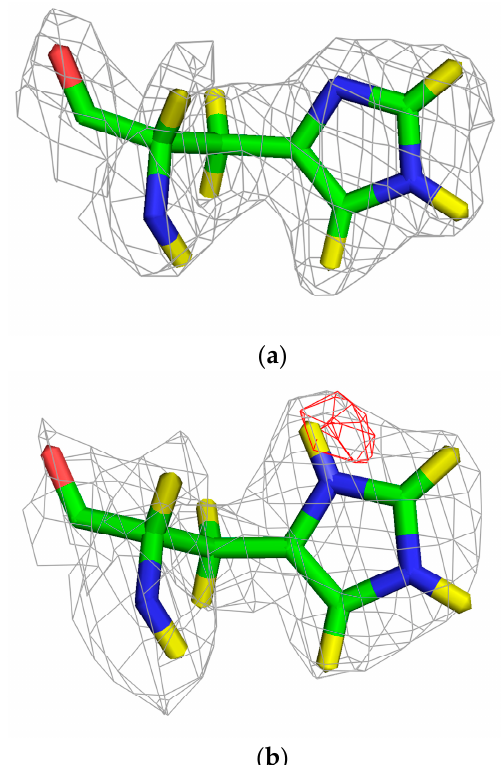
Figure 4. Protonation state of His30 in human MnSOD revealed by neutron diffraction. Carbons are green, nitrogens are blue, and oxygens are red. Deuterium (yellow) replaced hydrogen in the sample to increase diffraction signal. The 2F o -F c grey nuclear density is 1.0 σ . The red omit positive F o -F C nuclear density is at 2.5 σ . ( a ) Chain A of the neutron crystal structure displays an unprotonated His30. ( b ) Chain B shows a protonated His30. Methods and statistics for crystal growth,